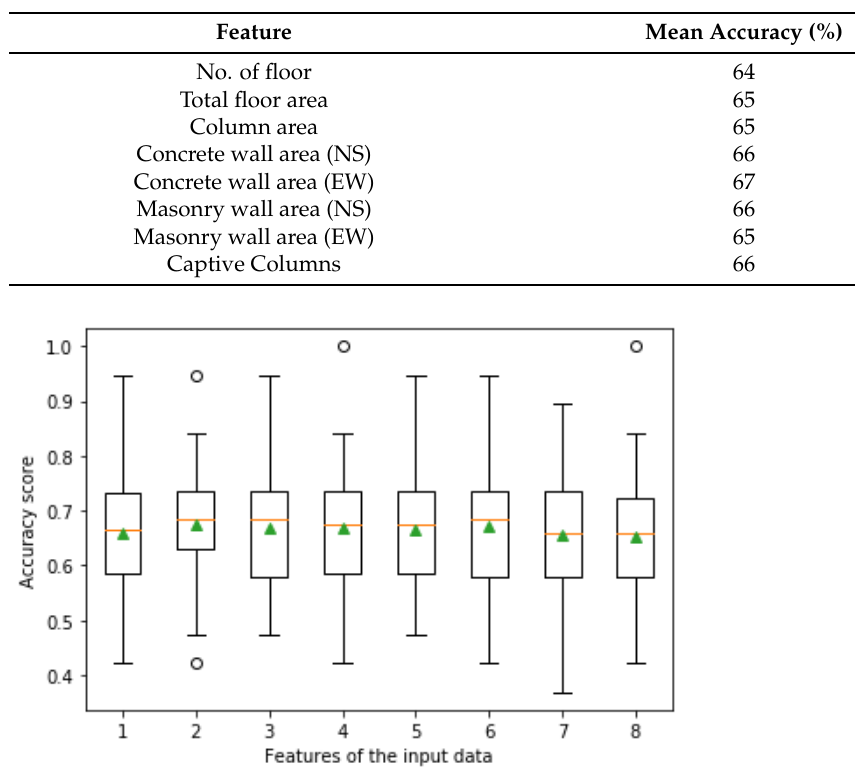
Figure 15. Ecuador: Boxplot to represent the mean accuracy distribution achieved by hyper-tuning the input features.